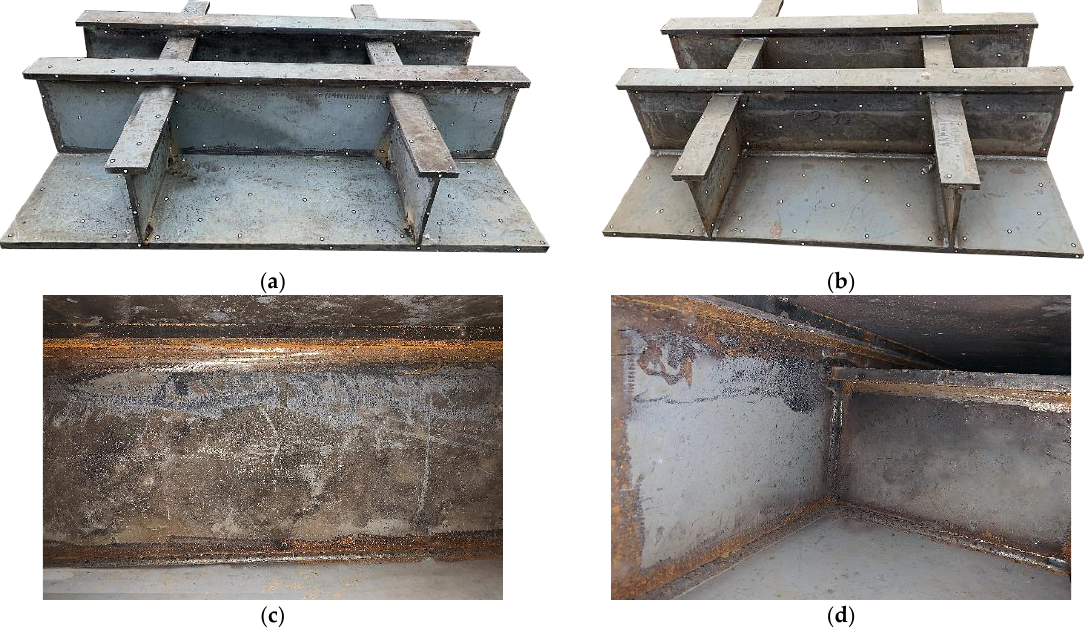
Figure 2. Comparison of stiffened plate specimens before and after welding. ( a ) Before welding; ( b ) after welding; ( c ) the weld between web and panel; ( d ) the weld between webs. Table 3. Welding process parameters of the stiffened plate specimens.